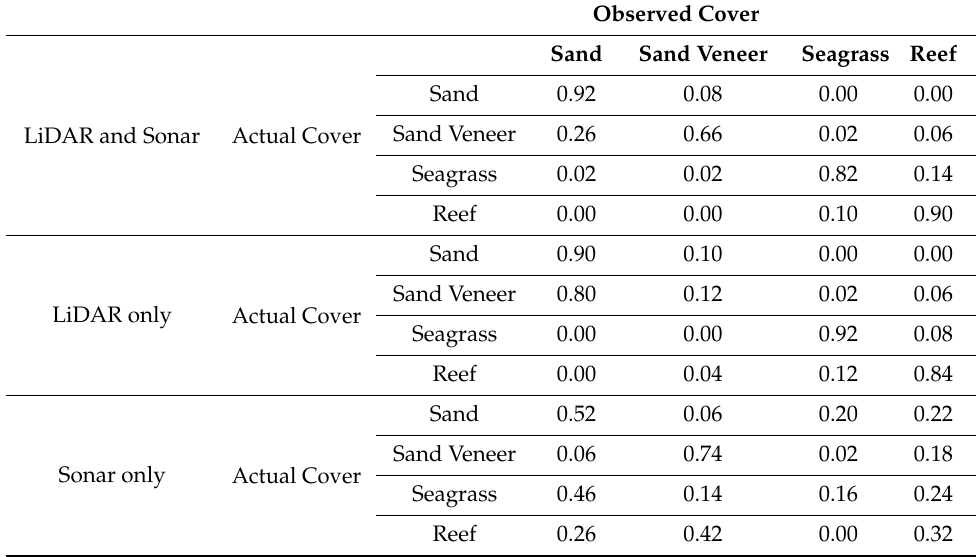
Table 5. Confusion matrix for the maximum likelihood